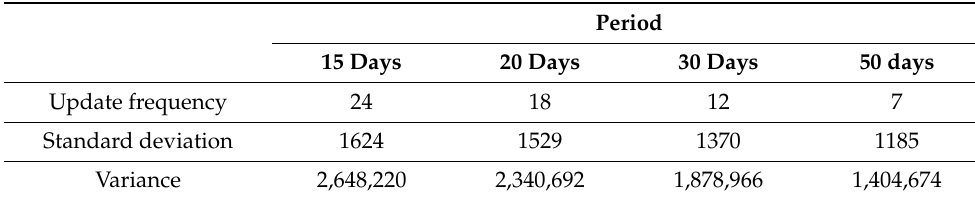
Table 4. Data from the different time periods of